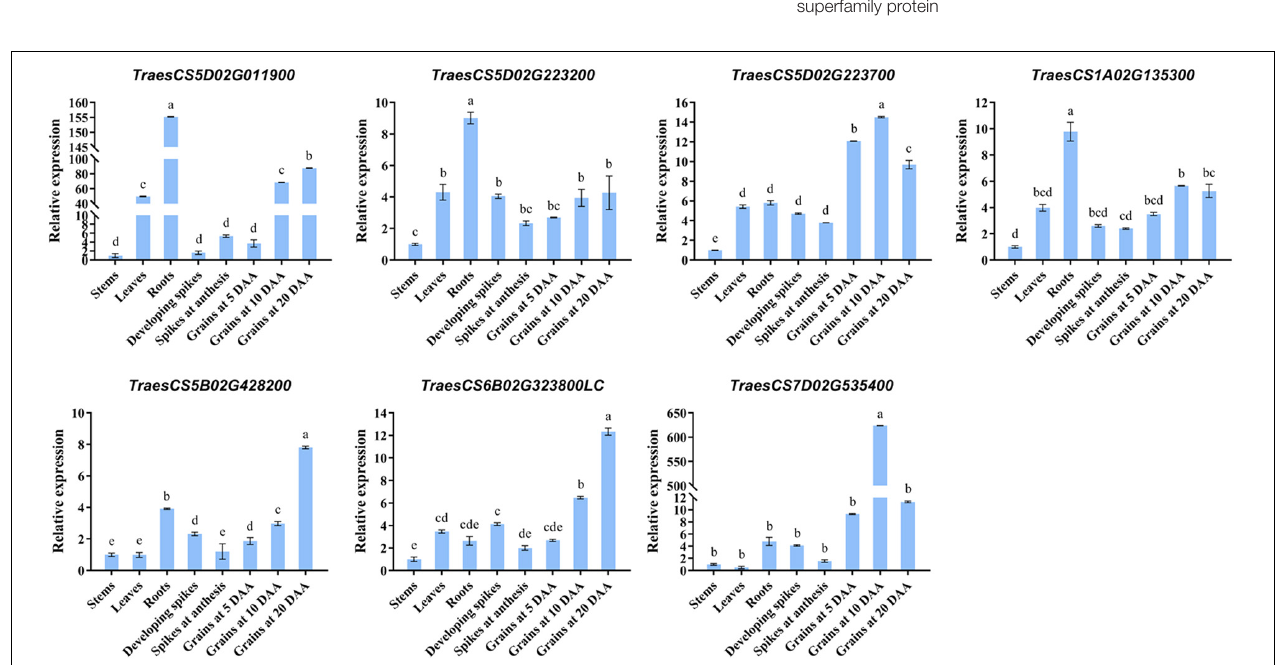
FIGURE 7 | Relative expression level of different tissues obtained from qRT-PCR analysis. Roots, stems, and leaves were collected at the three-leaf stage. Spikes were collected at developing (length: 40–60 mm) and anthesis. Grains were collected at 5, 10, and 20 days after anthesis (DAA). Data are the mean ± standard deviation of three biological replicates. The different letters are significantly different at P < 0.05 according to Duncan’s multiple range